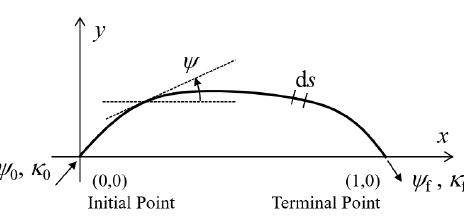
Figure 2. Definitions of the coordinate and states.